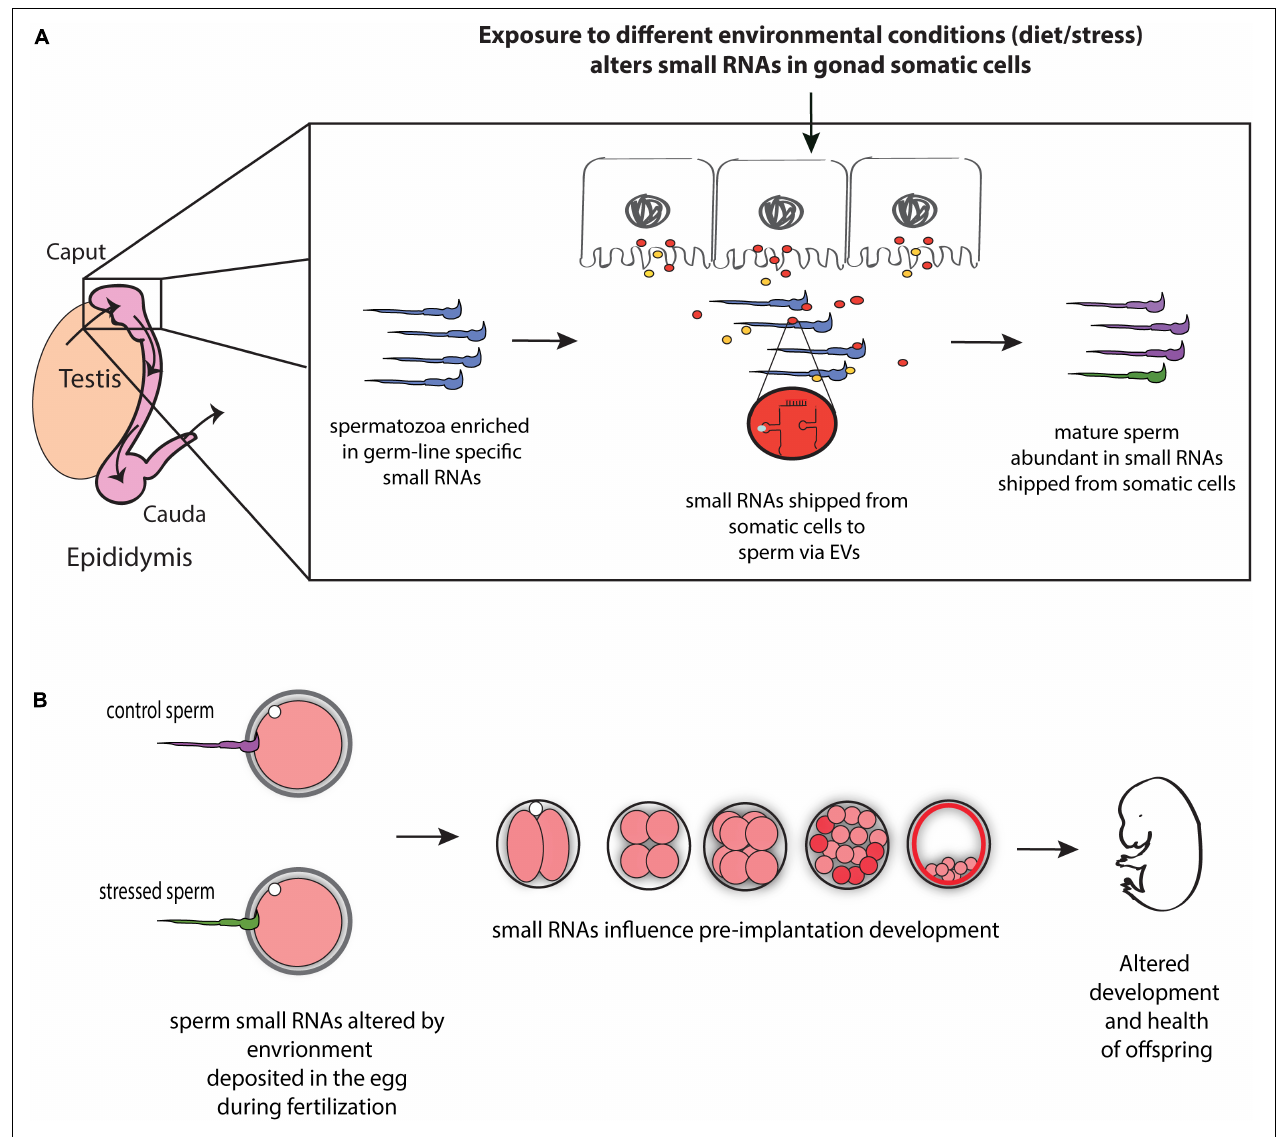
FIGURE 1 | Model for the role of RNA-mediated soma-germline communication in intergenerational inheritance. (A) During spermatogenesis and post-testicular maturation, small RNAs generated in the gonad somatic cells (for instance, epididymis) are shipped to sperm via extracellular vesicles (EVs) (and potentially as RNA bound to proteins). The abundance and/or shipment of these small RNAs can be modulated by environmental conditions, leading to an altered small RNA payload of sperm. (B) Sperm small RNAs are delivered to the oocyte at fertilization where they potentially affect early embryonic gene expression, resulting in altered early development and health of adult